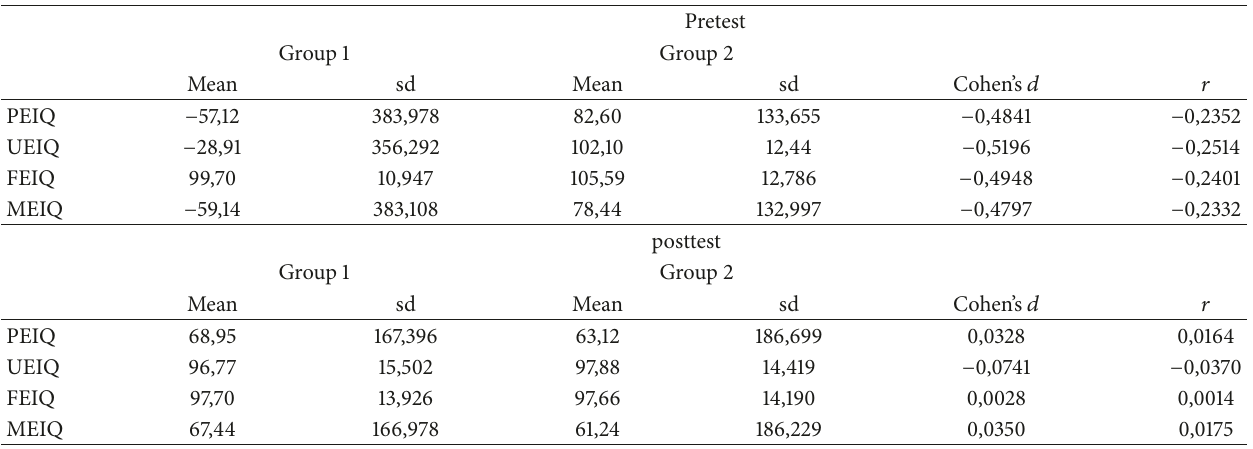
Table 8: Means, standard deviations, and effect sizes for all